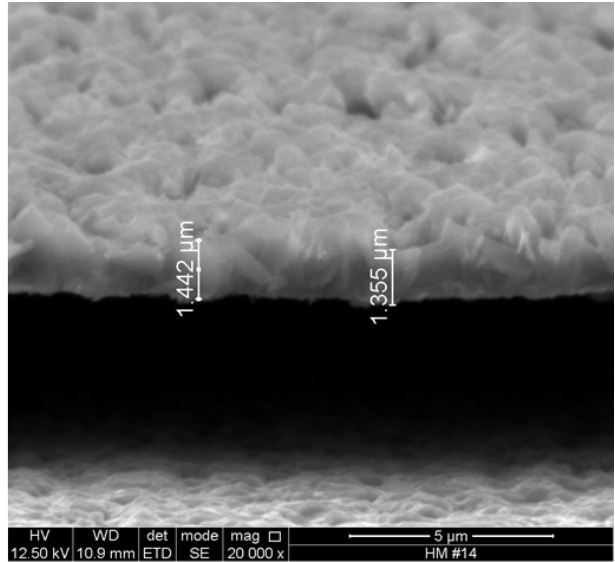
Figure 3. SEM image of the polyhedral Cu 2 O insulating film. The electrical impedance measurement of an insulating Cu 2 O film in Figure 4 is pre- sented. The fitting circuit model using a parallel circuit shows that the film has a DC resistance of order 9 × 10 3 M Ω (red curve) which corresponds to the resistance of an in- sulating material. The inset compares the insulating oxide film with a semiconducting Cu 2 O film which presents a resistance of 100 K Ω (black curve), corroborating that the Cu 2 O film obtained by thermal synthesis has an electrical insulating behavior. The literature shows evidence of a relationship between facet architecture and the electrical conduc- tivity properties of Cu 2 O crystals [3]. In our insulating films, we observed a mixture of polyhedral